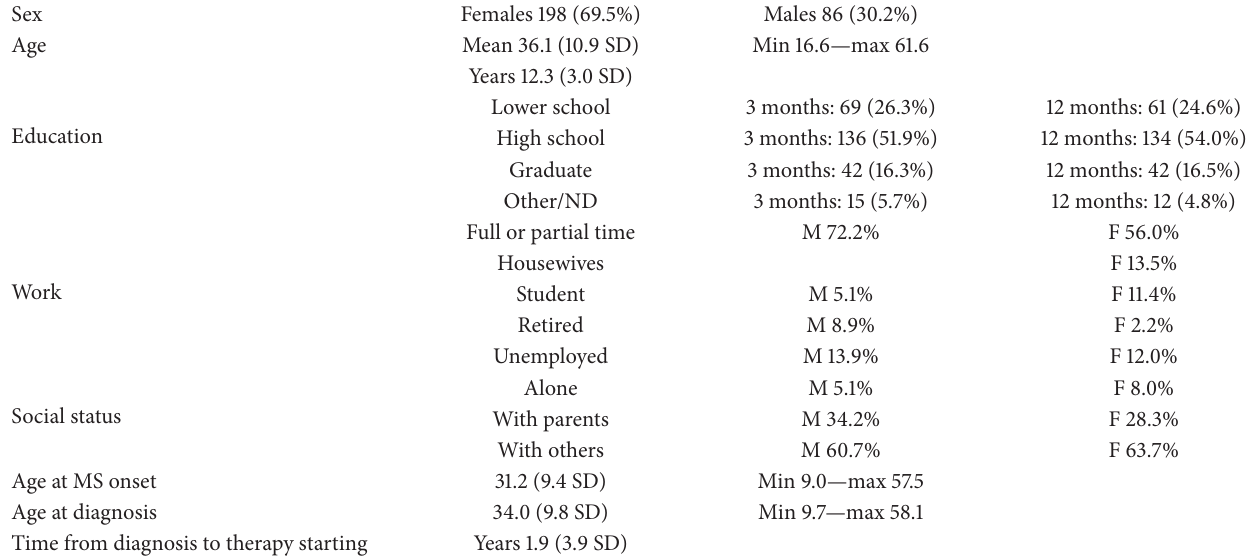
Table 1: Demographic data.